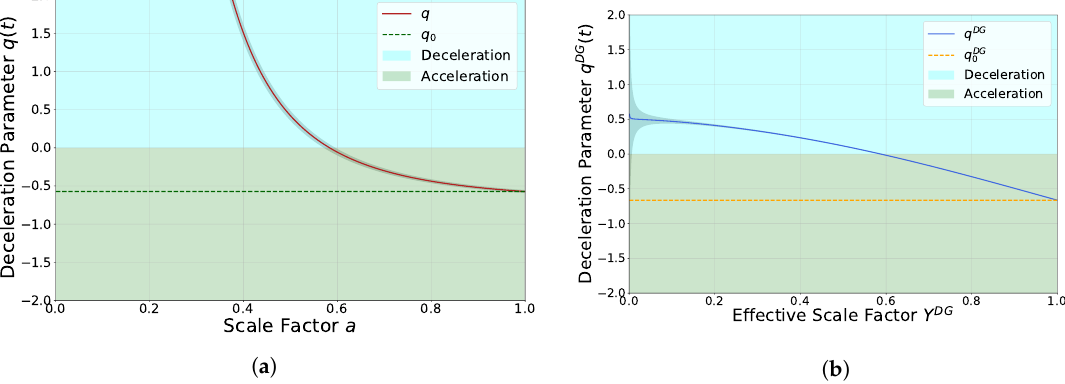
Figure 10. Deceleration parameter for both models. ( a ) Evolution of deceleration parameter in GR. ( b ) Evolution of deceleration parameter in Delta